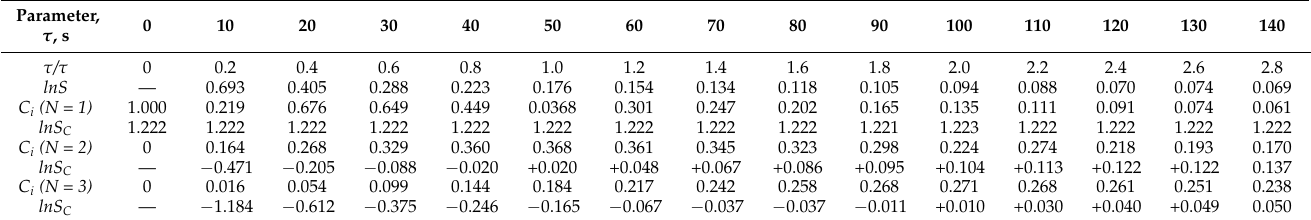
Table 1. Indicator concentration in the CSTR in series for various time intervals.